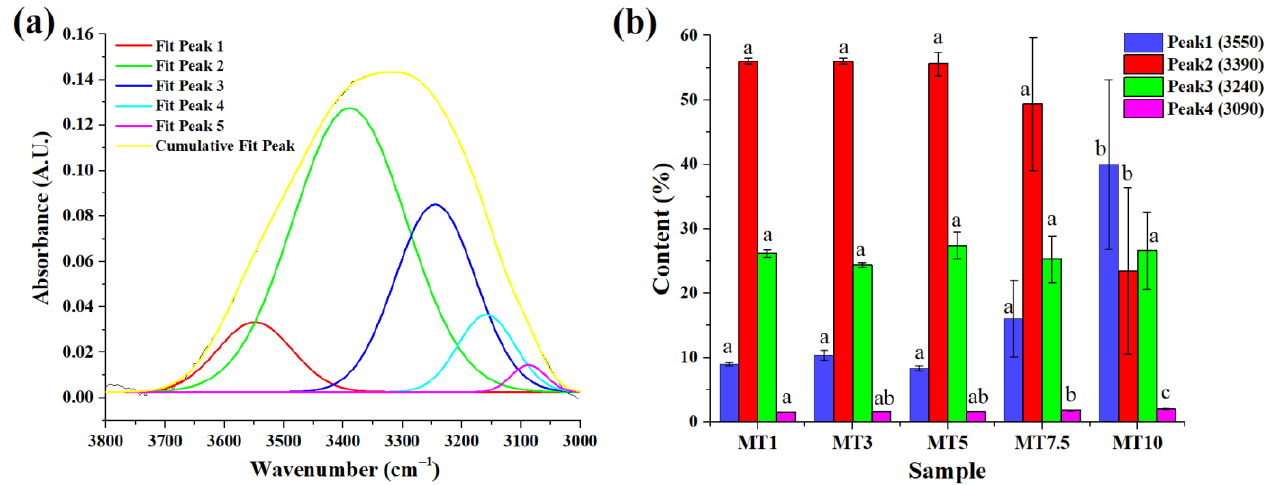
Figure 6. Graphs showing ( a ) a representative deconvoluted band of the water region and ( b ) variation of different peaks obtained in the water region concerning different samples. The alphabets above columns of the same color denote statistically significant ( p < 0.05) differences.